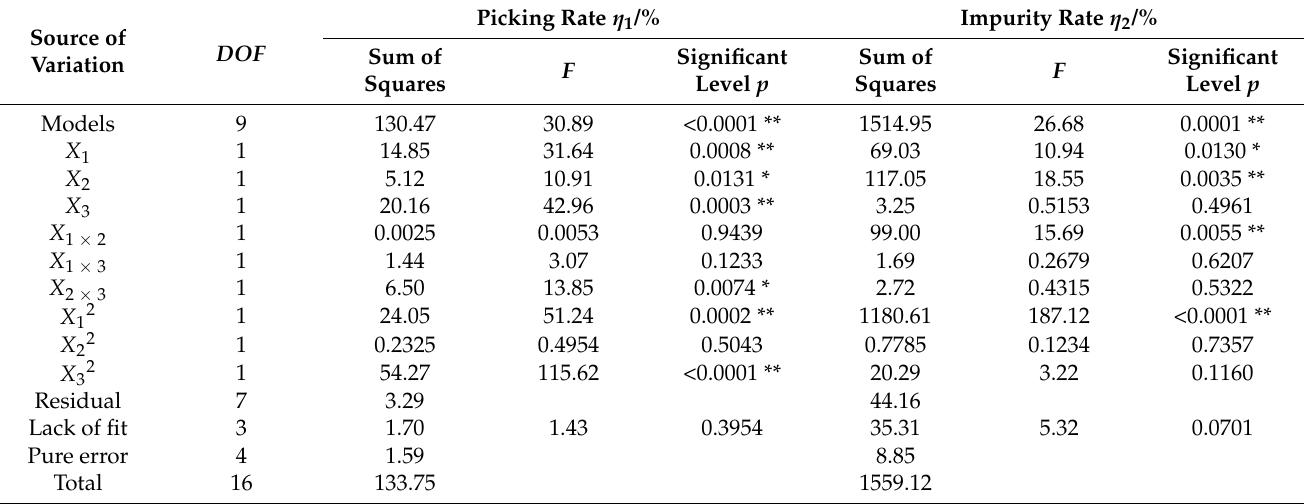
Table 5. Analysis of variance of regression